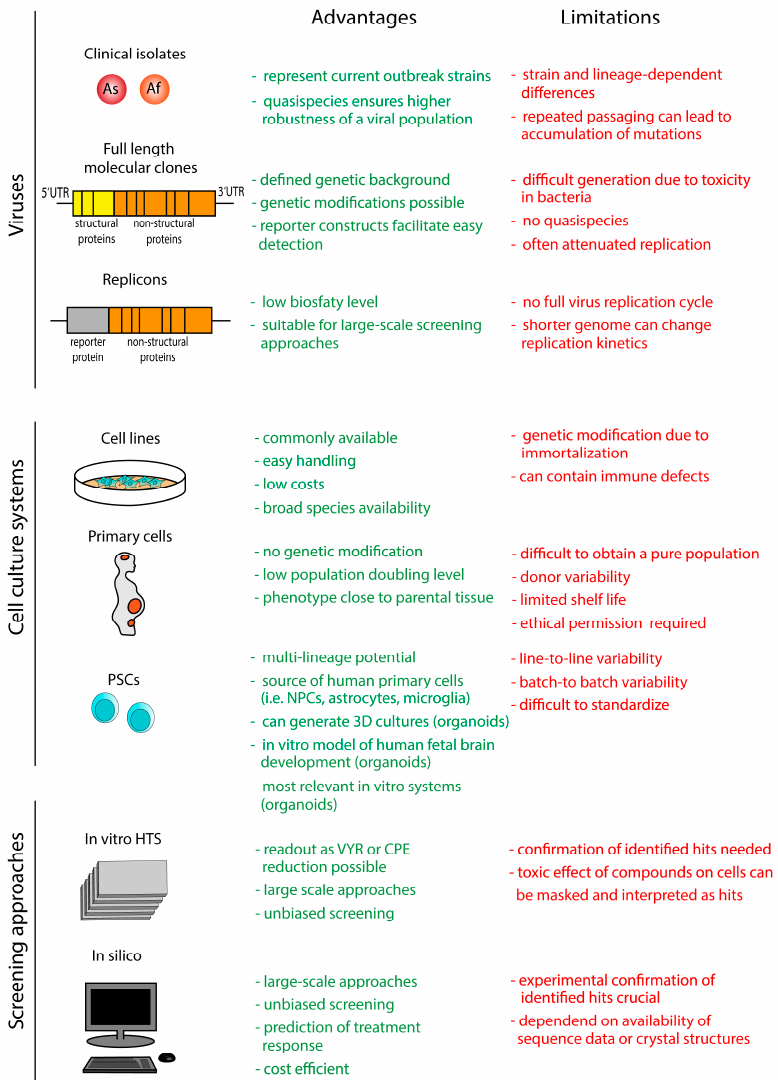
Figure 2. In vitro systems and screening approaches used for antiviral compound development against ZIKV. The text highlighted in green and red indicates advantages and limitations, respectively. PSCs: pluripotent stem cells, HTS: high-throughput screening, VYR: virus yield reduction, CPE: cytopathic effect.